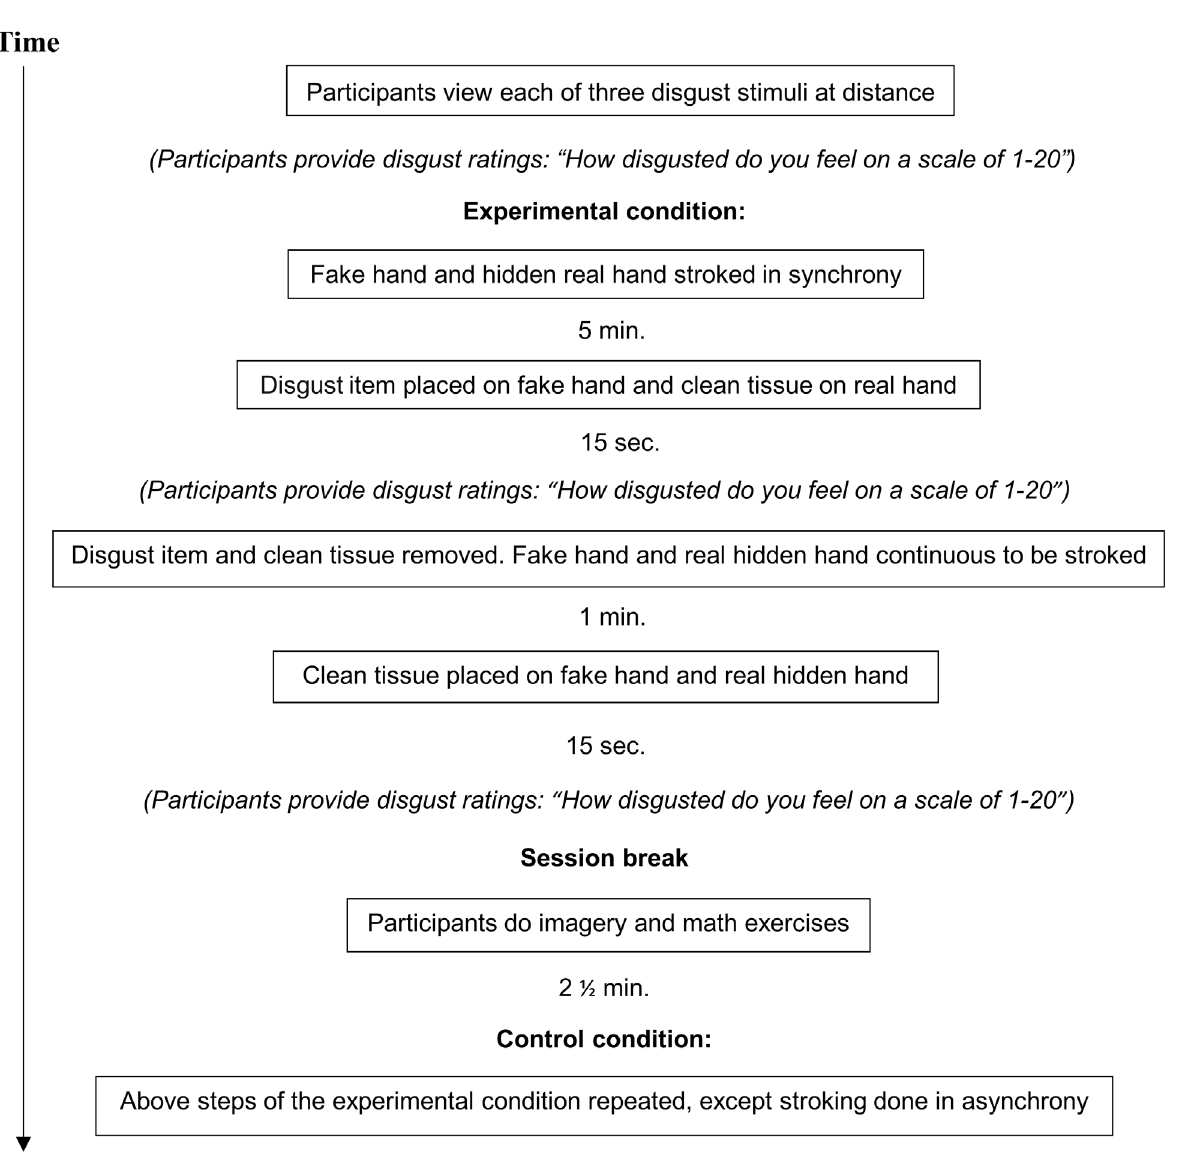
Fig 1. Overview of the experimental and the control condition. (A) The order in which the experimental and control condition were completed was